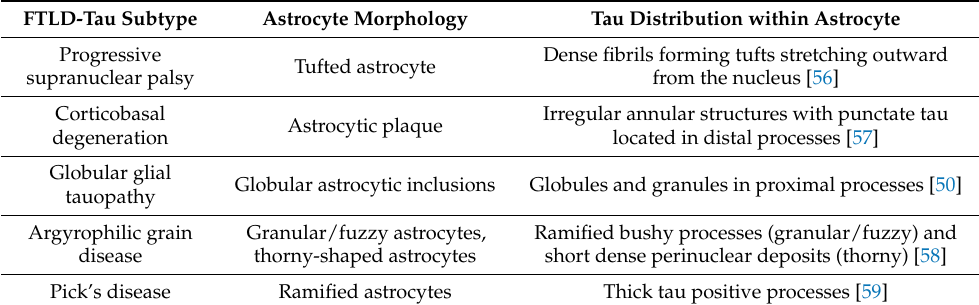
Table 2. FTLD-tau astrocytic